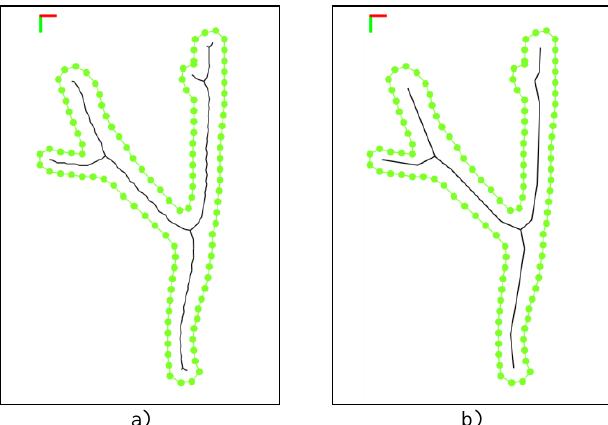
Figure 6. Component skeleton. a) Set of embedded Voronoi edges. b) Skeleton after applying filtering and smoothing.